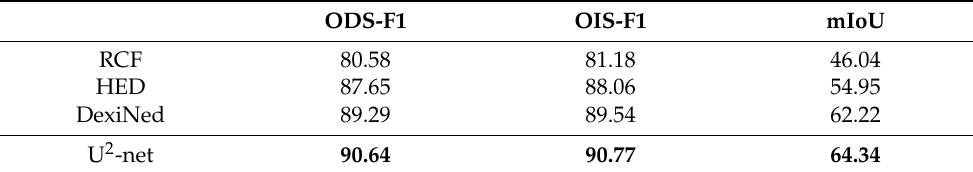
Table 3. Experimental results on the WHU dataset with edge detection